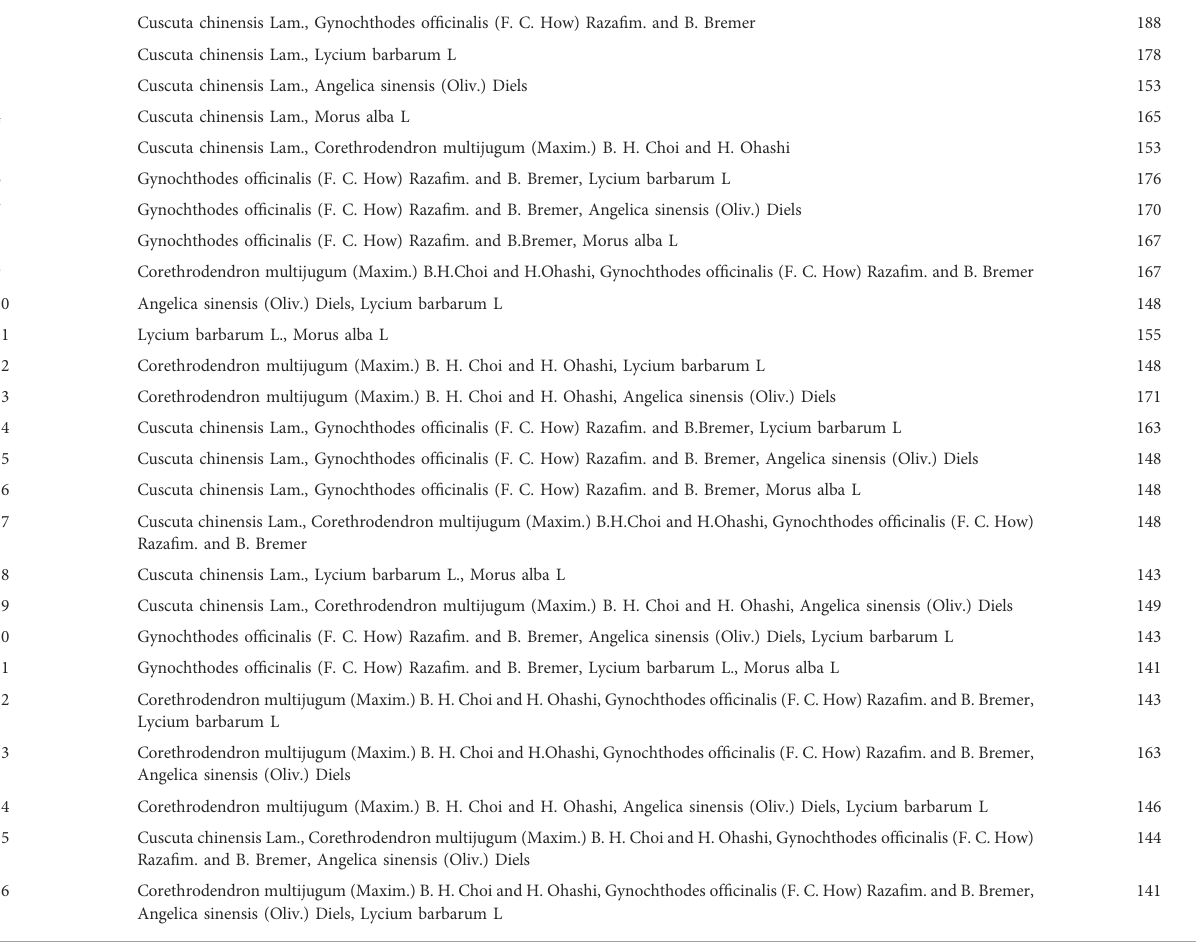
TABLE 2 The combinations of CCMM in TCM prescriptions. Number The combinations of